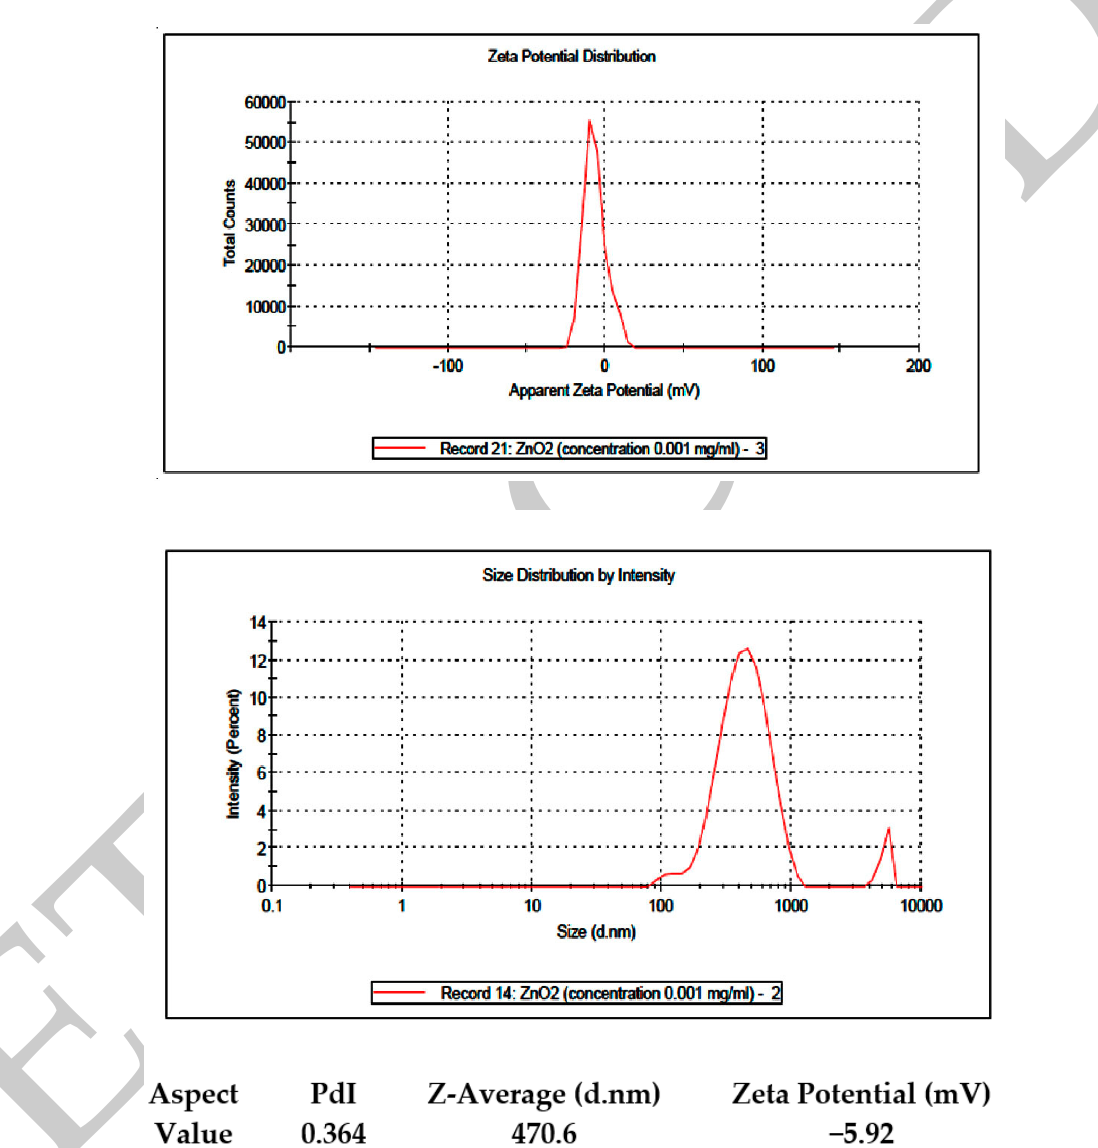
Figure 4. Zeta potential and Size distribution of the synthesized ZnO ‐ NPs.